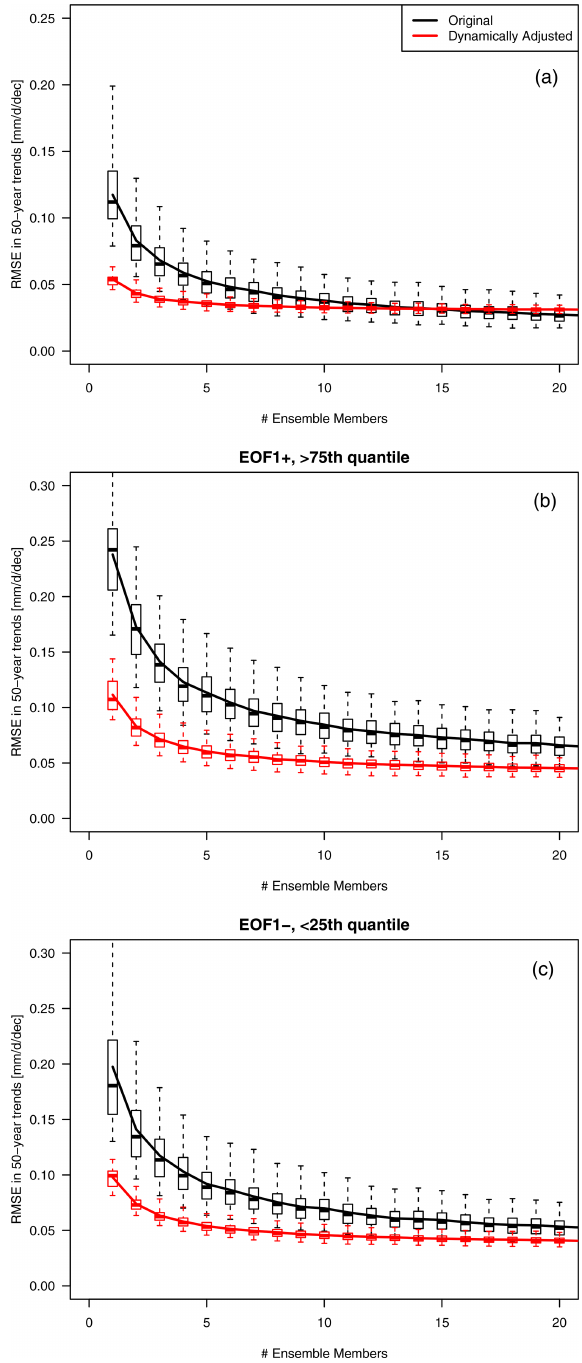
Figure 8. RMSE of 50-year trends, calculated by averaging n mem- bers, compared to 50-year trends using 50-member ensemble av- erage (“forced response”). RMSEs are based on land grid cells only and shown for averaging n original ensemble members (black) and averaging n dynamically adjusted ensemble members (red). Trends are calculated over the entire DJF season (a) and only for EOF1+ (b) and EOF1- situations (c) . Boxplot whiskers indicate 2.5th and 97.5th percentiles (boxes show 25th and 75th percentiles) of RMSE distribution obtained from bootstrapping from the 41 holdout ensemble